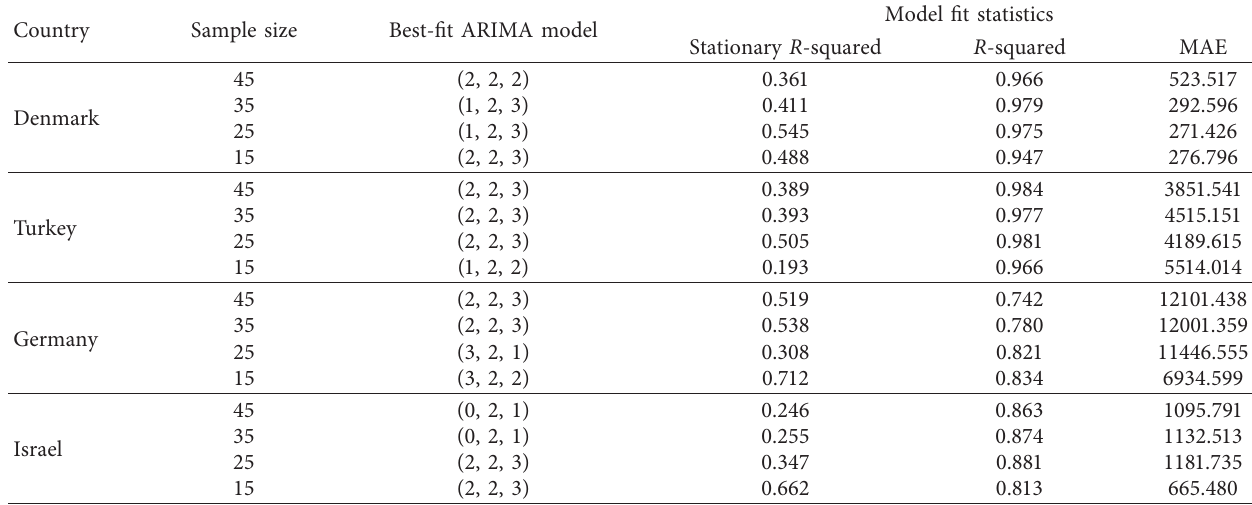
Table 4: The selected best-fit models for each sample size of all subject countries. Country